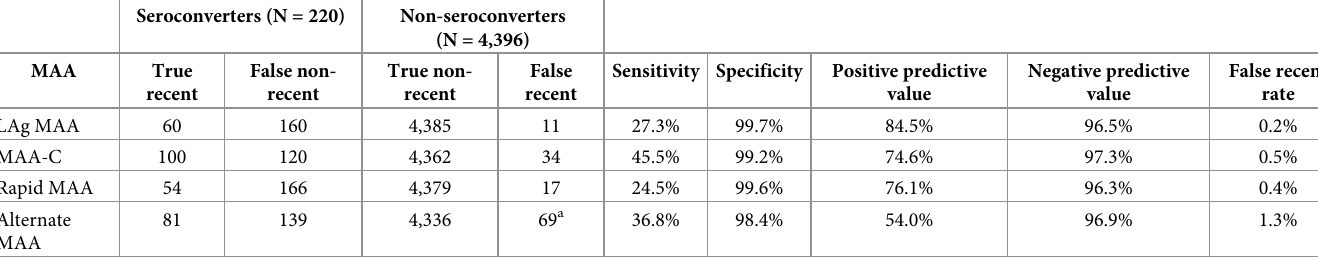
Table 2. Performance of multi-assay algorithms for identifying persons infected less than one year as recently infected. Seroconverters (N =